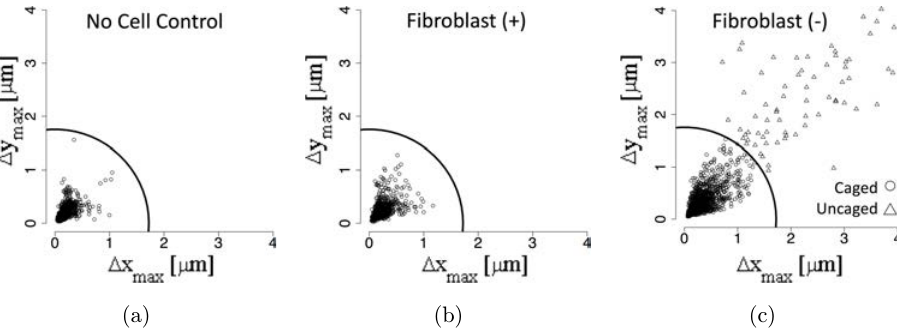
Fig. 4. Maximum displacement was recorded for all probes within a representative sample well for each of three conditions: (a) no cell control, (b) PANC1 and MRC-5 co-culture, and (c) PANC1 homoculture. The quarter circle at 1.72 (cid:1) m represents a threshold calculated from a clustering algorithmto quantitatively di®erentiate \caged" and \uncaged" probe trajectories. Average maximum probe displacement compared across conditions (d) further highlights their di®erences while the standard deviation of the mean seen here as error bars, underlines the large variation in the ¯broblast ( (cid:2) )